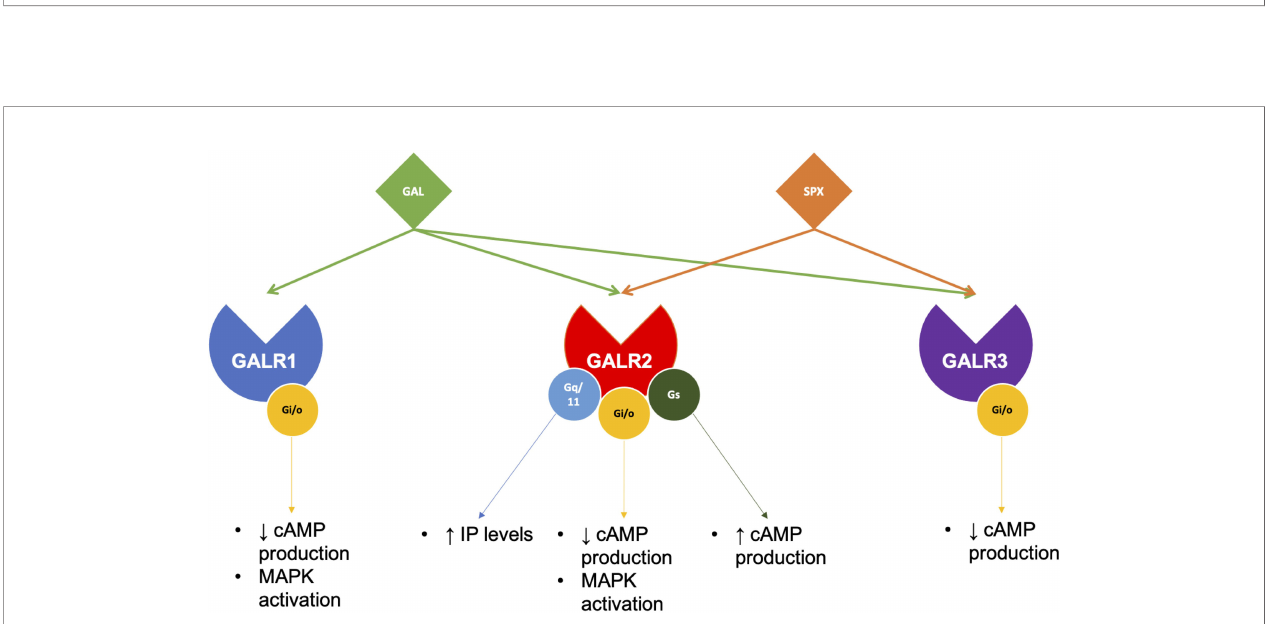
FIGURE 2 | Phylogenetic tree of SPX and GAL present in fi sh. Sequences obtained from GenBank. Phylogenetic construction was done in MEGA X, using the Neighbor-Joining method. The percentage of the sequences clustered together is shown on the branches, out of 1000. SPX and GAL form two distinct branches, with SPX1 and SPX2 dividing further.